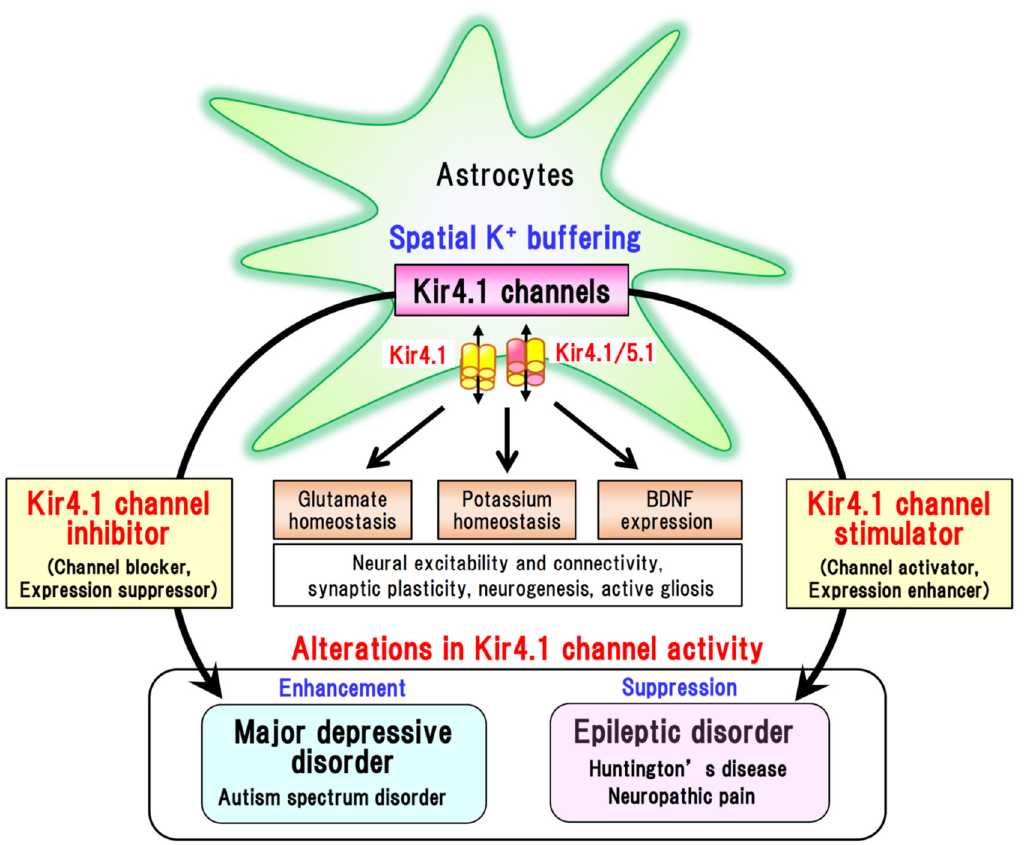
Figure 4. Dysfunction of Kir4.1 channels in brain diseases and potential glia-oriented therapeutic strategies. Kir4.1 channels mediate spatial K + buffering function of astrocytes and play important roles in the homeostatic maintenance of extracellular potassium and glutamate levels in tripartite synapses. They also modulate the astrocytic expression of BDNF, a key molecule for neural plasticity and neurogenesis. The functions of Kir4.1 channels are attenuated in epileptic disorders and other brain diseases, including Huntington’s disease and neuropathic pain. In contrast, Kir4.1 channel functions are probably enhanced in major depressive disorder and autism spectrum disorder. Although further investigations are necessary, recent evidence suggest that Kir4.1 can serve as a glia-oriented novel target for the treatment of brain disease. In particular, Kir4.1 channel stimulators (e.g., channel activators or expressional enhancers) are anticipated to serve as therapeutic agents for the former diseases, Kir4.1 channel inhibitors (e.g., channel blockers or expressional suppressors) could be administered for the latter diseases.